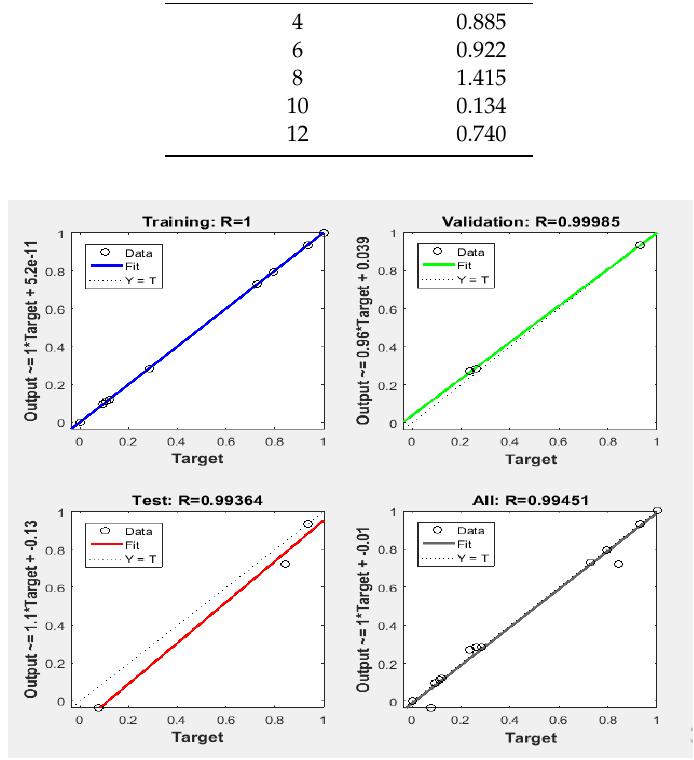
Figure 3. Correlation plots of predicted versus experimental data for the artificial neural network-moth-flame optimization (ANN-MFO)